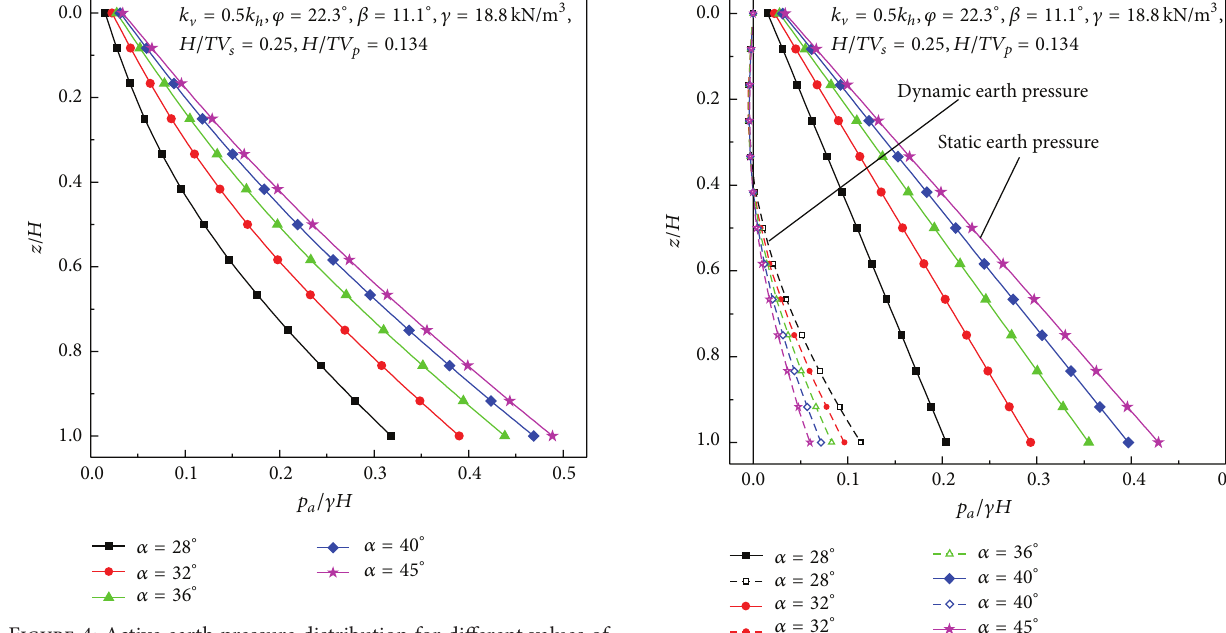
Figure 4: Active earth pressure distribution for different values of rupture angle, 𝛼 .